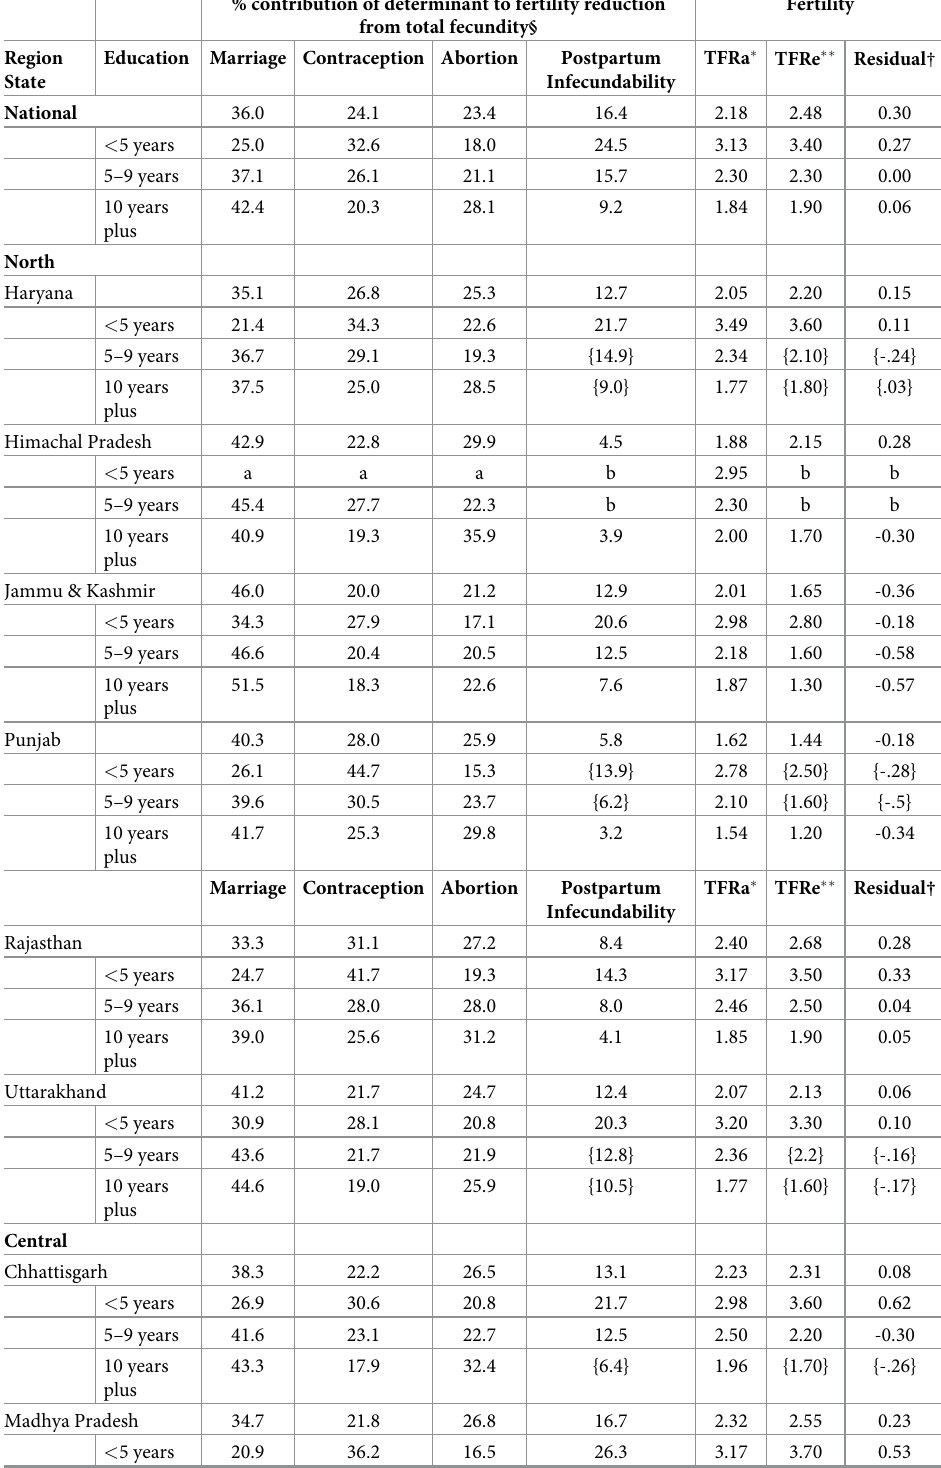
Table 4. Estimates of the percent contribution of four key proximate determinants to fertility reduction, actual TFR, estimated TFR and residual by education: National and by state, India